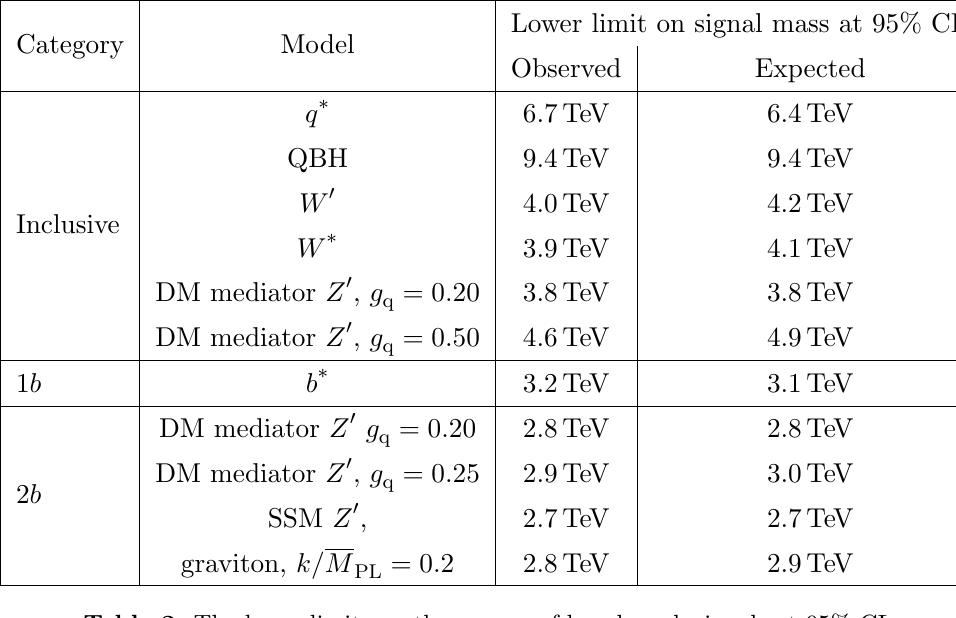
Table 2 . The lower limits on the masses of benchmark signals at 95% CL.